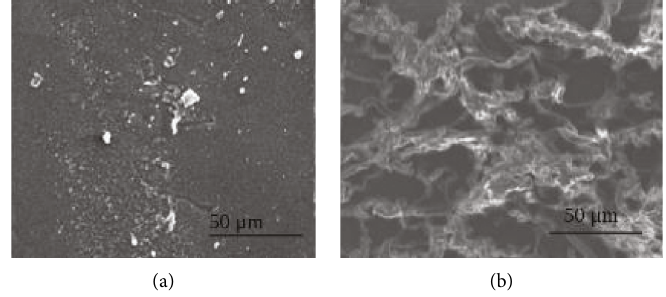
Figure 7: SEM images of (a) plastic film before and (b) after